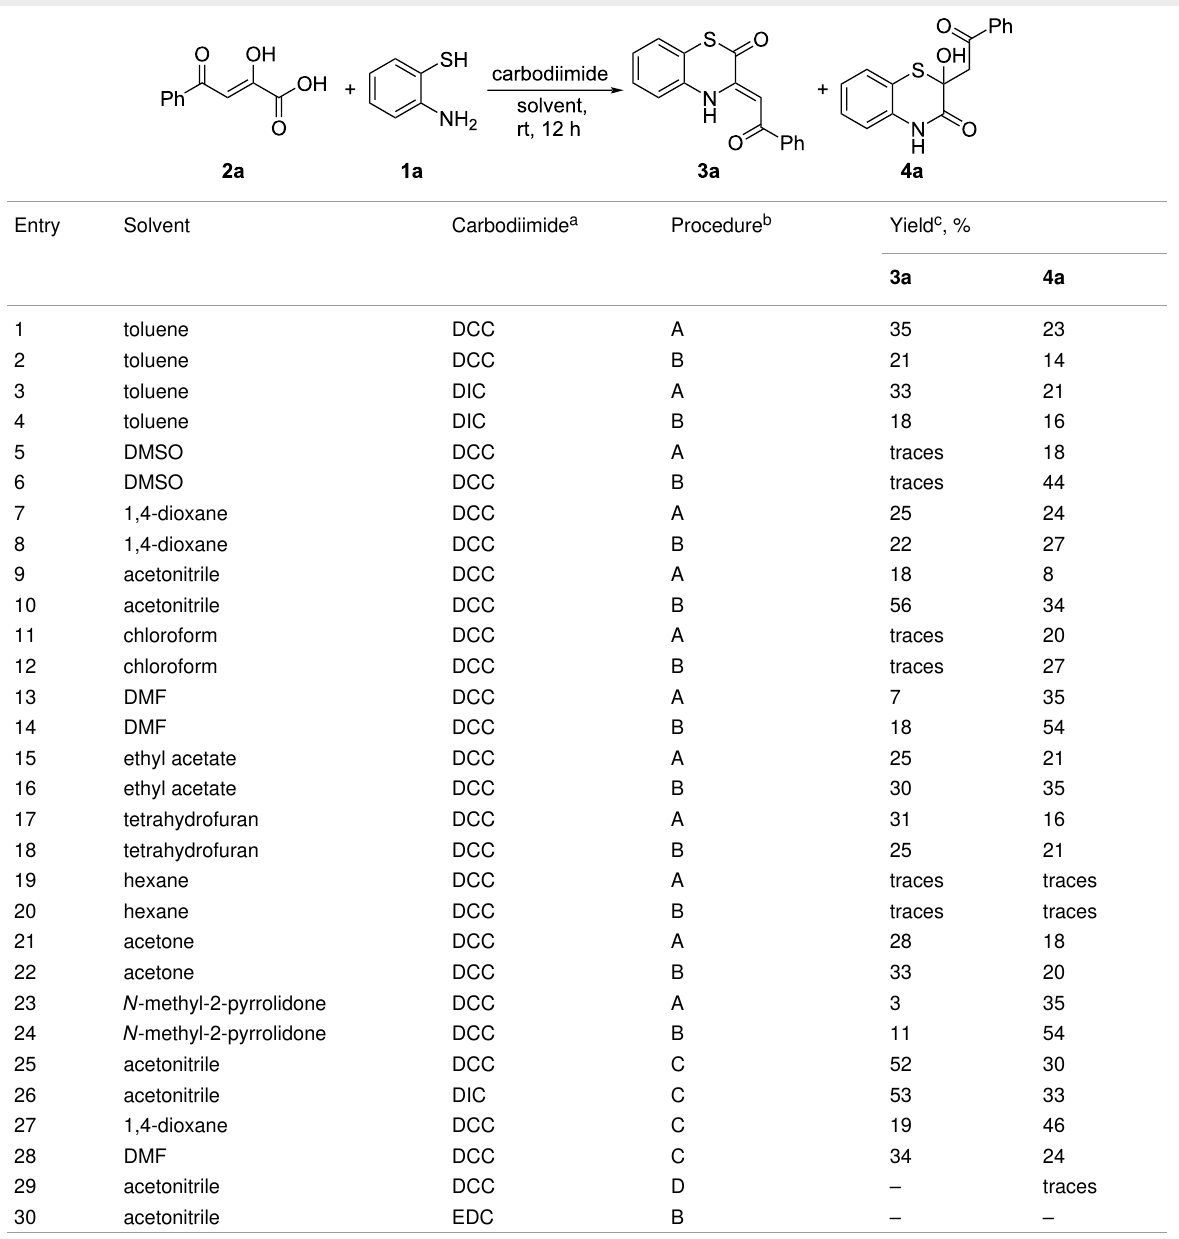
Table 1: Reaction of acylpyruvic acid 2a with o -aminothiophenol ( 1a ) in the presence of carbodiimides in various